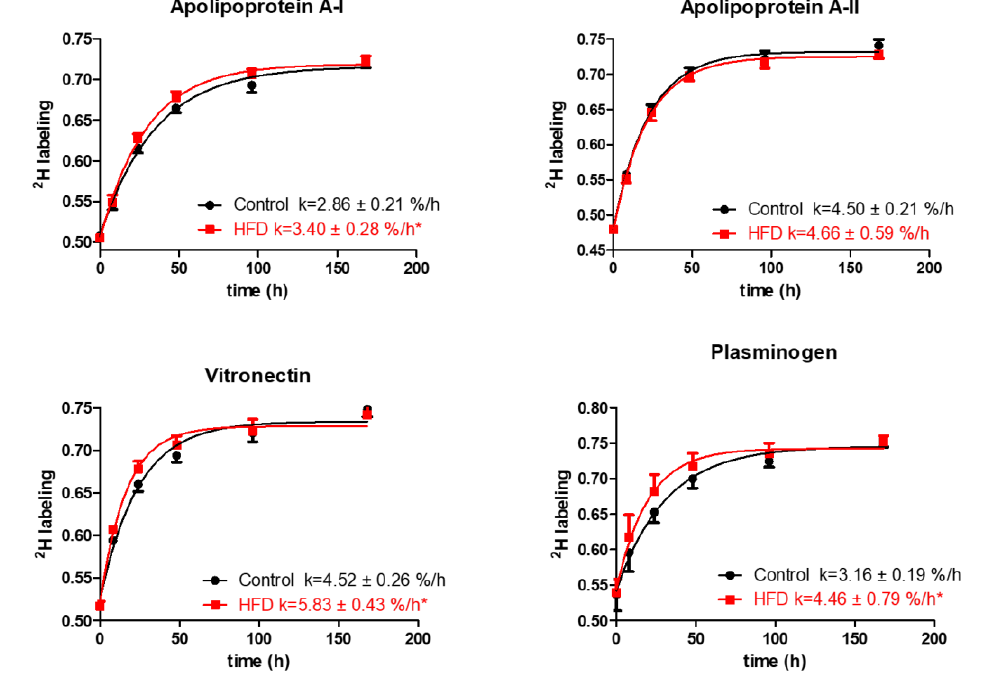
Figure 4. Typical kinetics curves of HDL proteins. The time course of 2 H-labeling of apolipoprotein A-I, apolipoprotein A-II, vitronectin, and plasminogen peptides is shown for mice fed either the control diet or the HFD groups. The fractional catabolic rate is denoted by the rate constant k. Statistical significance, * indicates p < 0.05 compared to control.